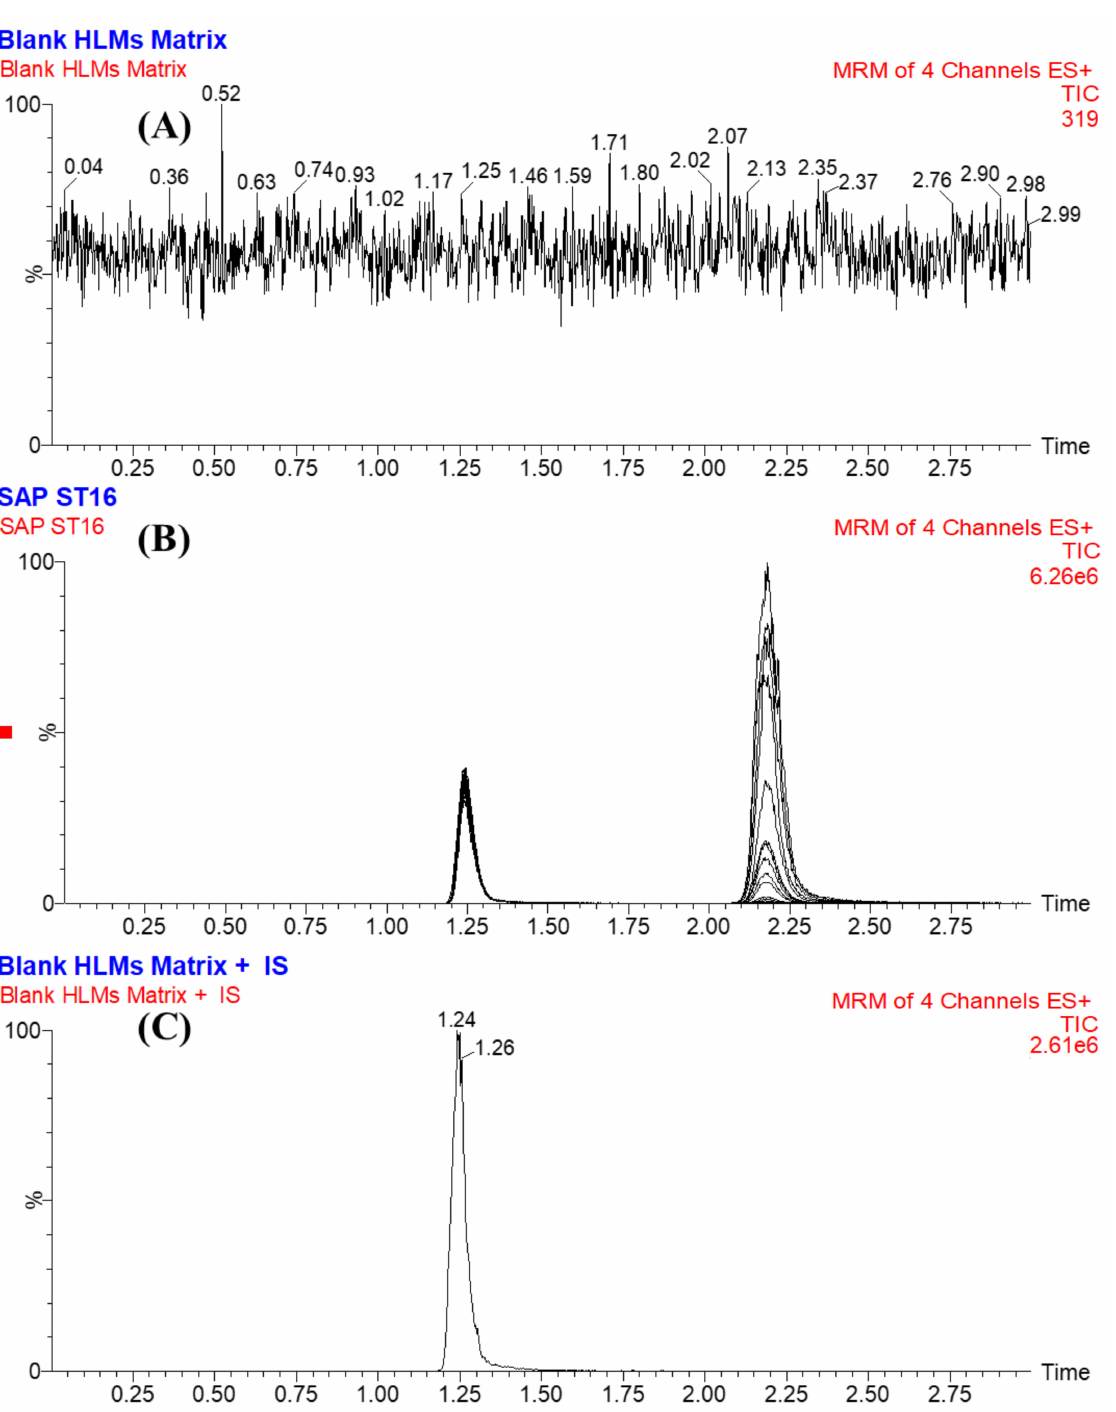
Figure 4. Blank HLM matrix showing no interfering peaks at the retention times of SPT and FGT ( A ) and overlaid MRM chromatograms of the SPT calibration levels ( B ) showing the SPT peak (2.1 min) and FGT peak (1.1 min). MRM chromatograms of blank HLMs plus FGT ( C